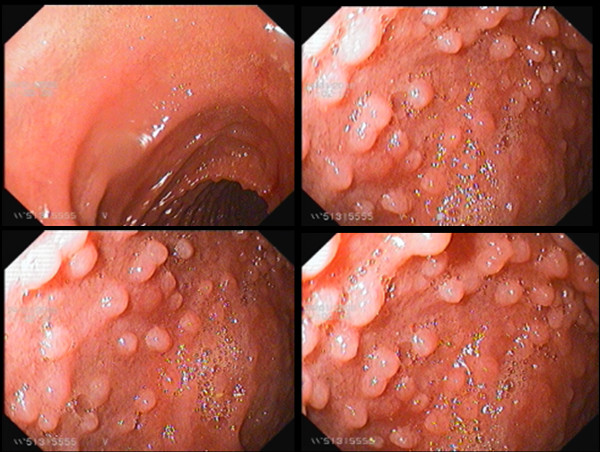
Diffuse Duodenal Nodular Lymphoid Hyperplasia. 35 year male presented with epigastric pain, vomiting and weight loss of 5 kg over the past 6 months. Duodenal composite images. Top left image: Duodenal bulb revealed smooth mucosa without any nodular lesion. Top right and 2 bottom images: post-bulbar region, second and third part of duodenum showed diffuse numerous mucosal nodules (>5 mm size each) scored as grade 4 disease. There was complete loss of Kerckring's folds. Duodenal biopsies revealed nodular lymphoid hyperplasia. Immunoglobulin revealed mild elevation of IgG level [IgG 2090 mg/dl (normal 700-1600 mg/dl); IgM. 120 mg/dl (normal = 40-230 mg/dl); IgA 145 mg/dl (normal = 70-400 mg/dl)].